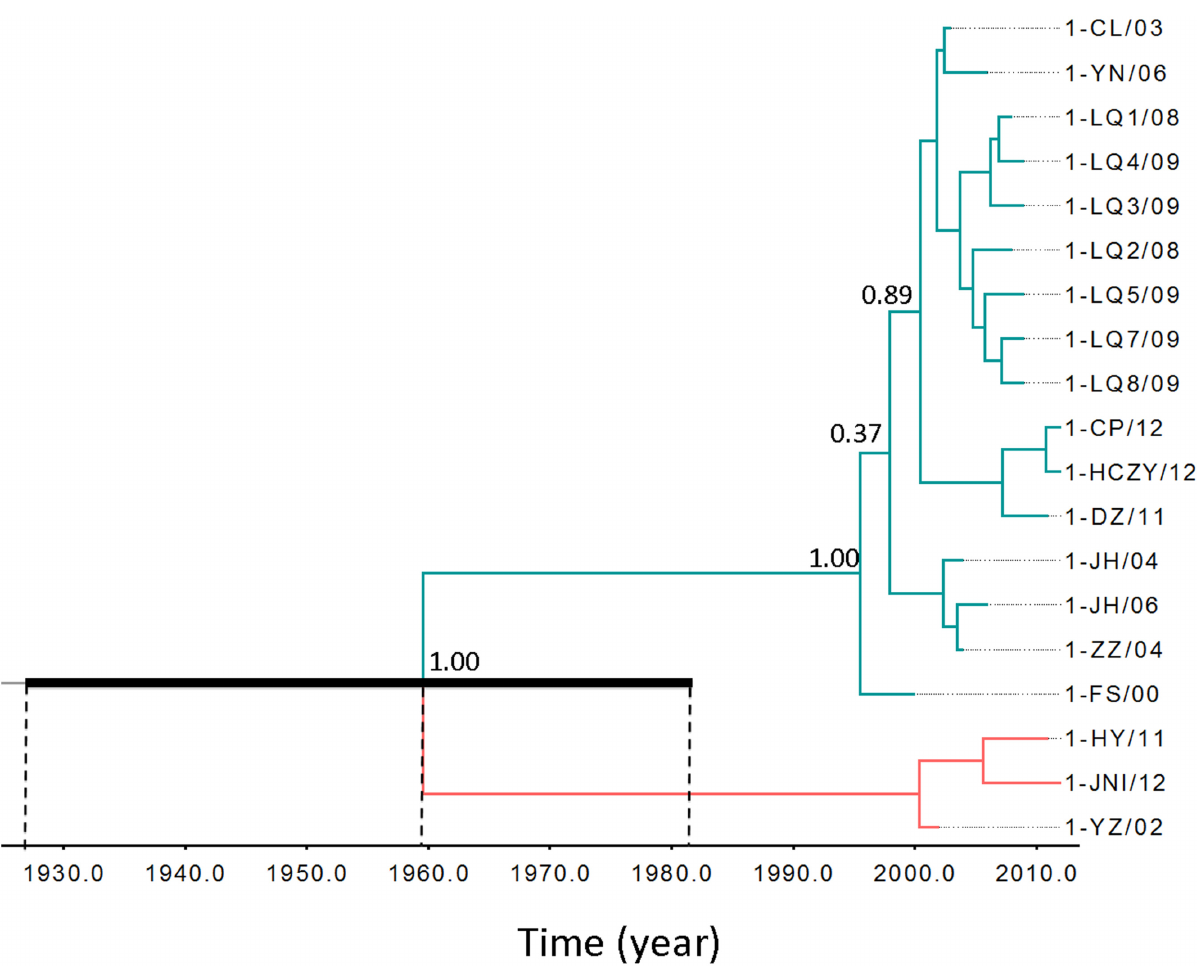
Fig 1. Bayesian Maximum Clade credibility tree of VP1 gene of DHAV-1 virus inferred using Beast program. The two lineages with probability support of 1 were colored green and red respectively. The probabilities of the most internal nodes were shown. The inferred divergence time was shown below the tree. The black bar represents 95% high probability interval for the most recent common ancestor. Virus strains were named in the order of serotype, abbreviations of isolation place and two digits isolation time. See materials section and Table 1 for abbreviations of isolates and their locations.